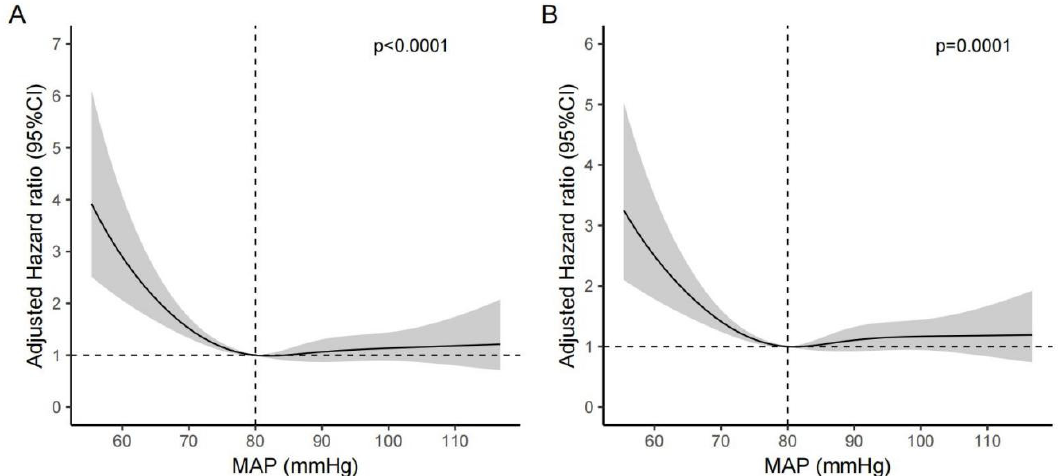
Figure 2. Crude non-linear association between MAP and the 7-day mortality ( A ) and 28-day mor- tality ( B ) in patients with acute stroke. The reference (hazard ratio = 1, horizontal dotted line) was an MAP of 80 mmHg (vertical dotted line).